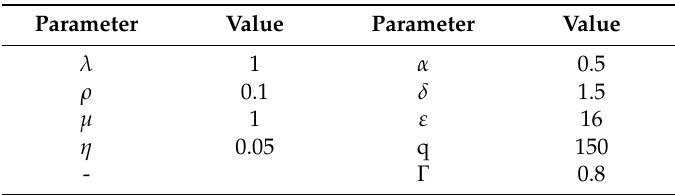
Table 7. The control parameters.